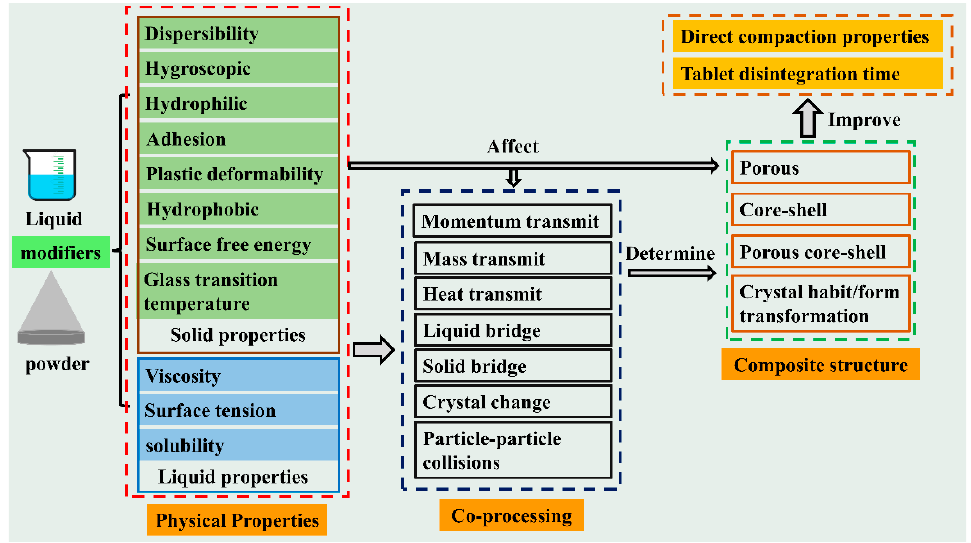
Figure 3. Mechanism of modifiers in improving direct compaction properties.